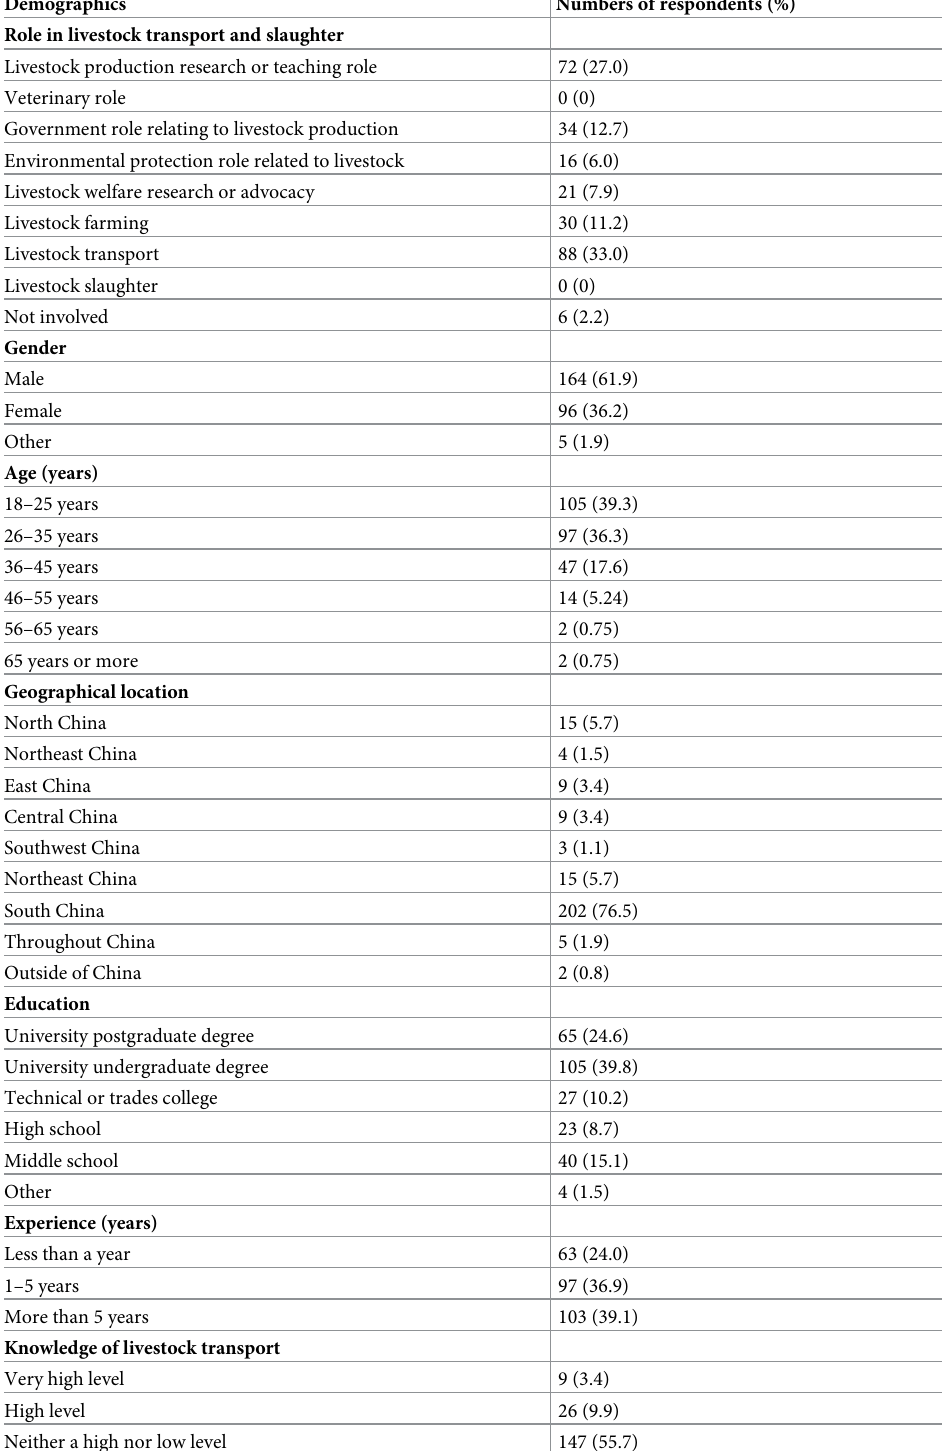
Table 2. Demographic characteristics of respondents, who were stakeholders in the animal transportation and slaughter sectors, to a questionnaire on the major welfare issues in the Chinese livestock transport and slaughter industry, as defined in an initial expert meeting (n =